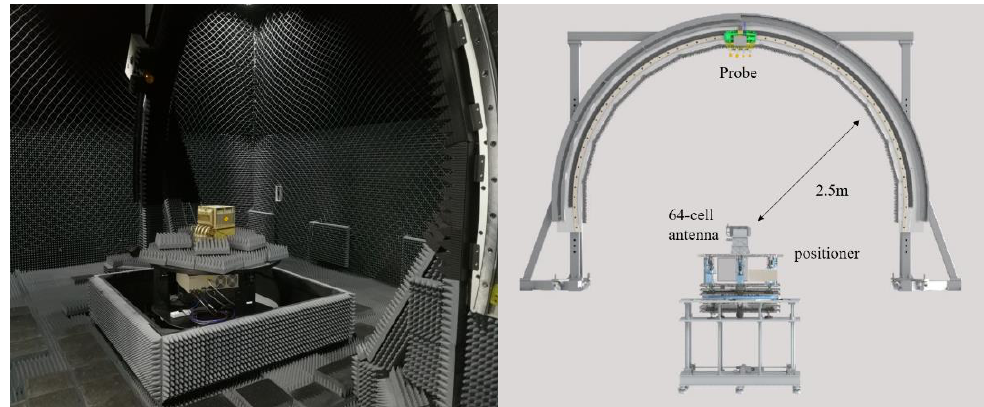
Figure 3. The 64-element PAA measured in a spherical range measurement system.